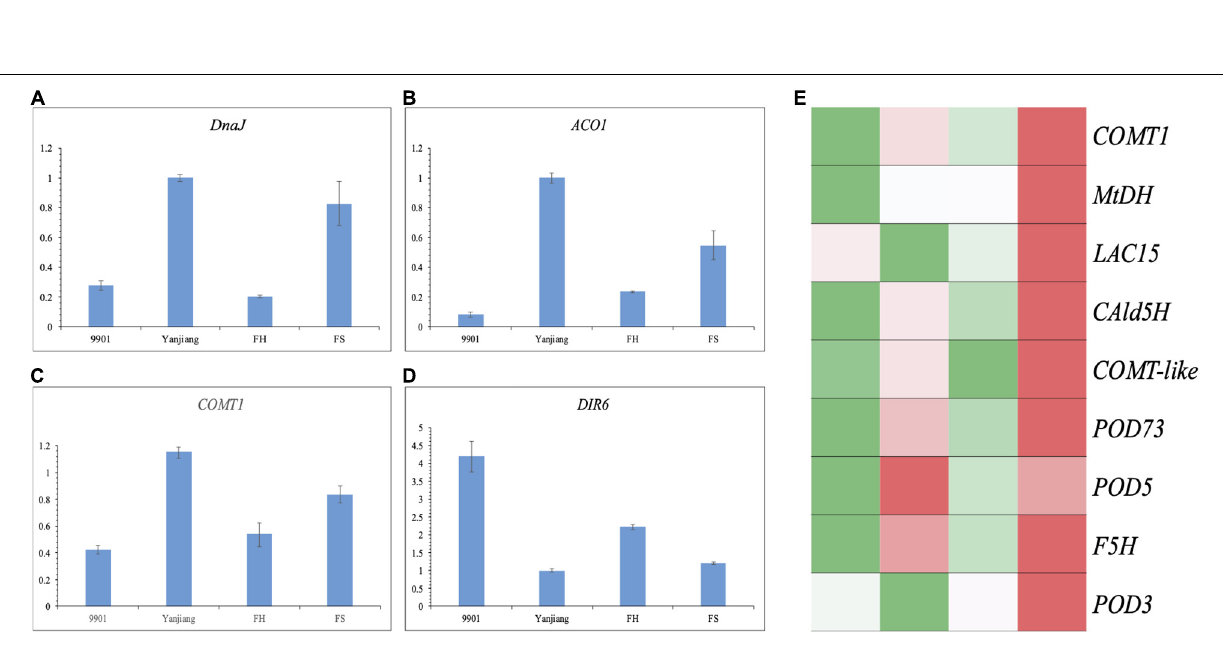
Frontiers in Genetics |